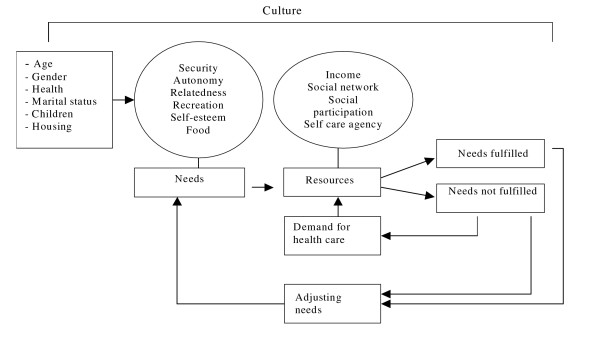
Relation between health care needs, resources and demands.